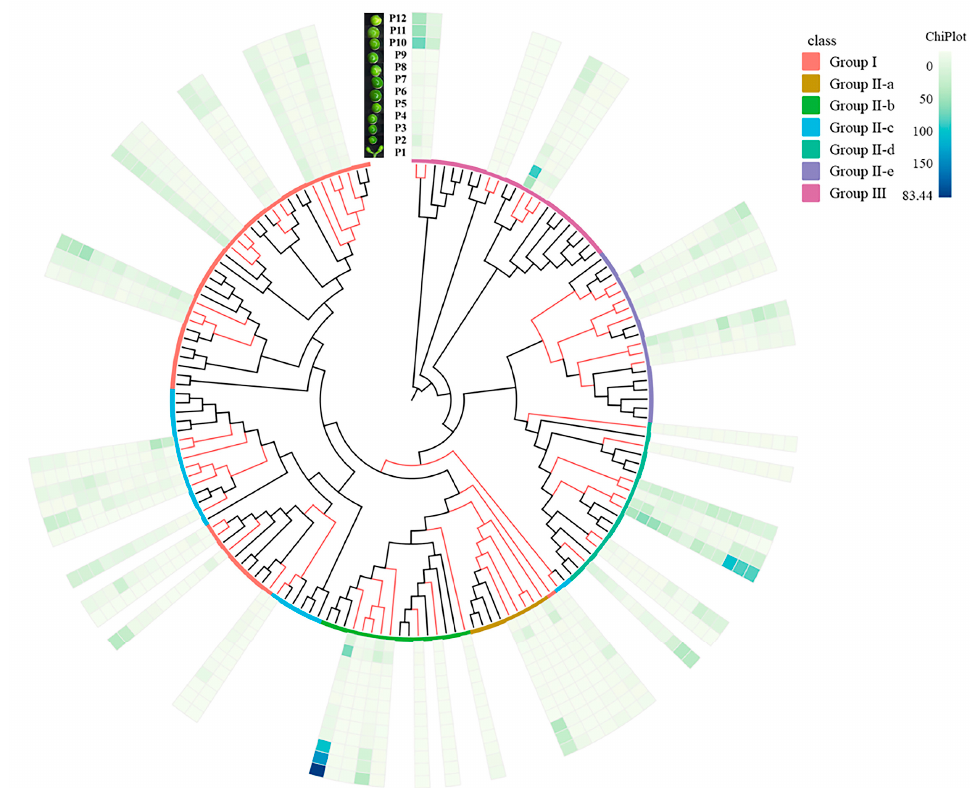
Figure 2. Maximum-likelihood phylogenetic tree of WRKY proteins in L. cubeba and A. thaliana . The phylogenetic analysis was constructed by MEGA11 software with bootstrap test of 1000 times. Seven subfamilies of WRKYs are distinguished by circles of different colors (Group I, Group IIa–e and Group III). Red and black branches represent LcWRKYs and AtWRKYs . The expression pattern of of LcWRKYs in different developmental periods of the L. cubeba fruits were investigated based on the RNA-seq data (PRJNA763042). P1–12 represent different developmental stages of fruits from L. cubeba : 15, 30, 45, 60, 75, 90, 105, 120, 135, 150 days after full bloom